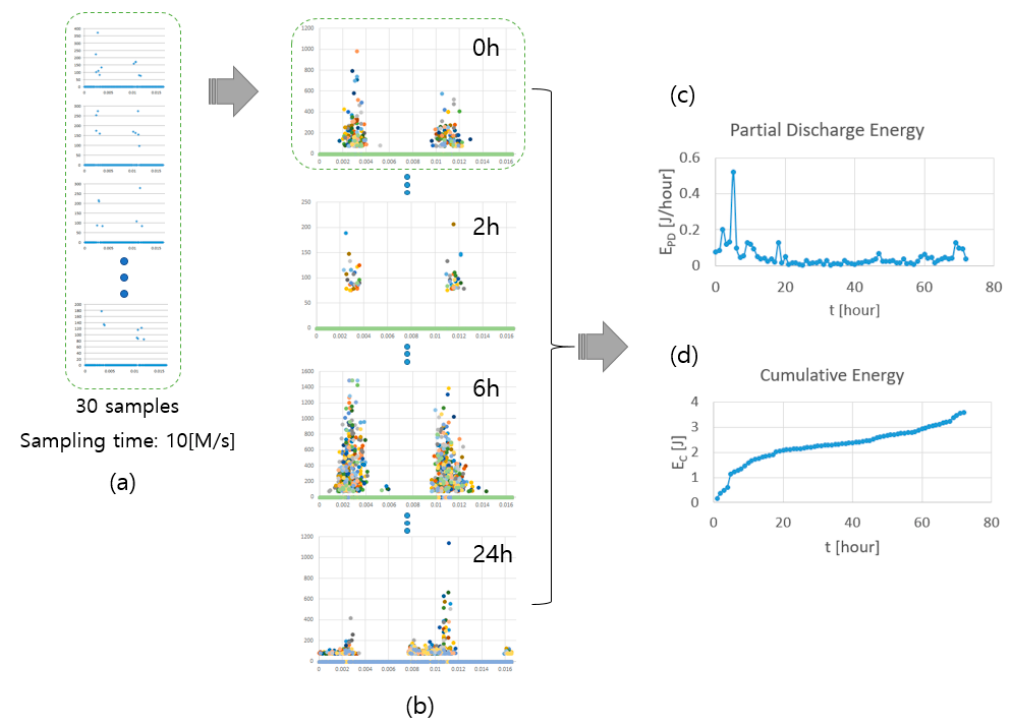
Figure 6. Partial discharge data processing for the cumulative energy evaluation: ( a ) extraction of 30 samples for the representative partial discharge (PD) pattern for each hour; ( b ) the representative PD pattern for each hour; ( c ) the partial discharge energy from the representative PD pattern; and ( d ) the integration of partial discharge energy.